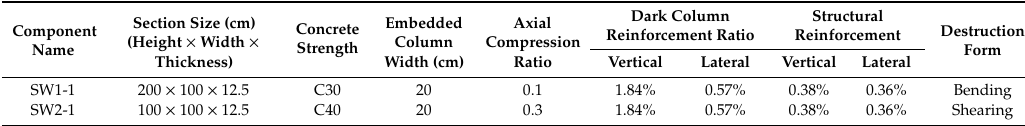
Table 2. Parameters of column components.